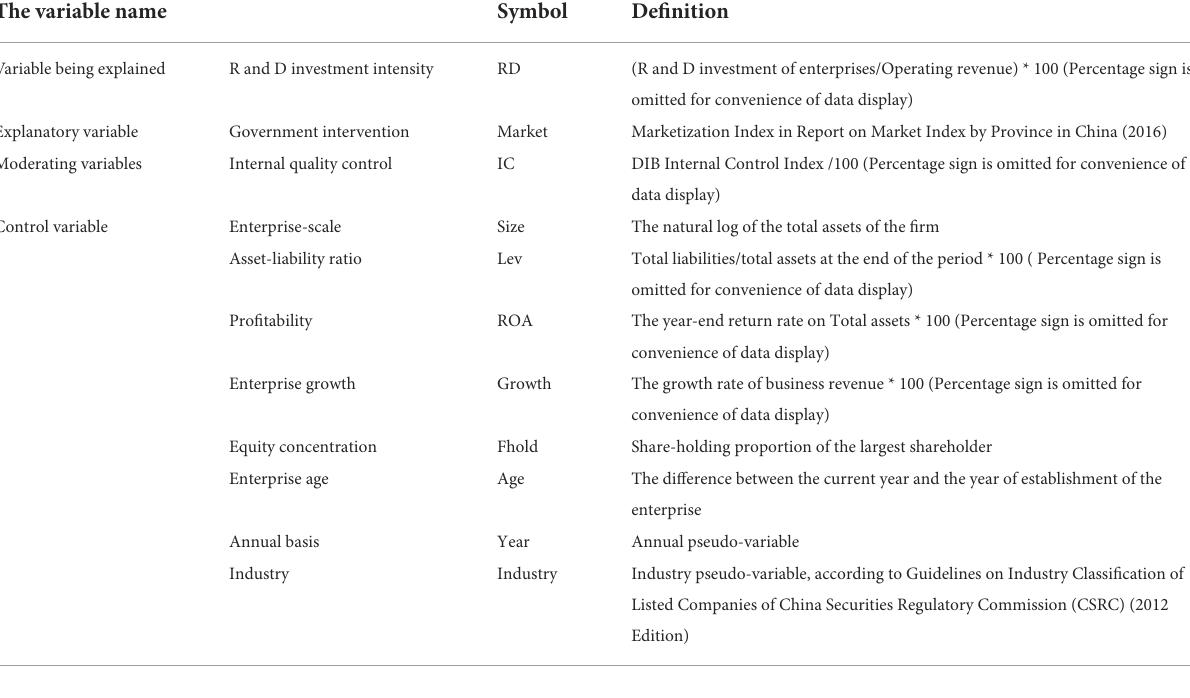
TABLE 1 Definition and description of study